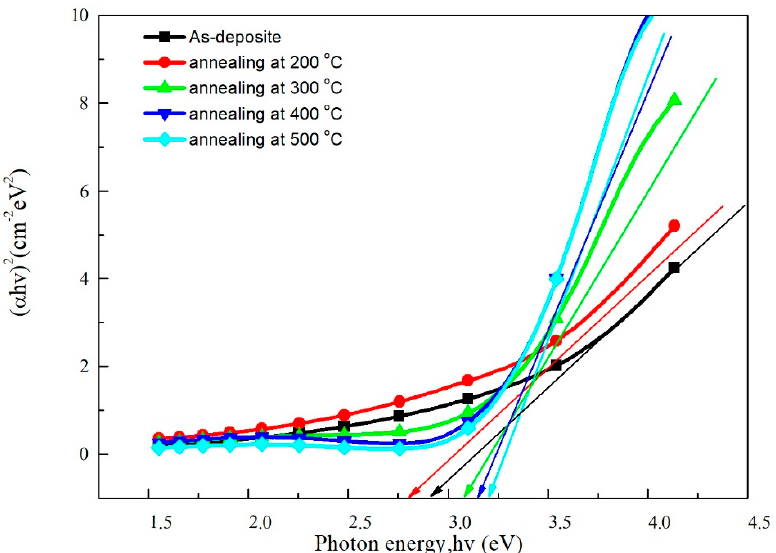
Figure4. The( α h ν ) 2 againstphotonenergy( h ν )ofTi:SnO 2 filmsunderdi ff Figure 4. The ( α h ν ) 2 against photon energy ( h ν ) of Ti:SnO 2 films under different annealing temperatures.